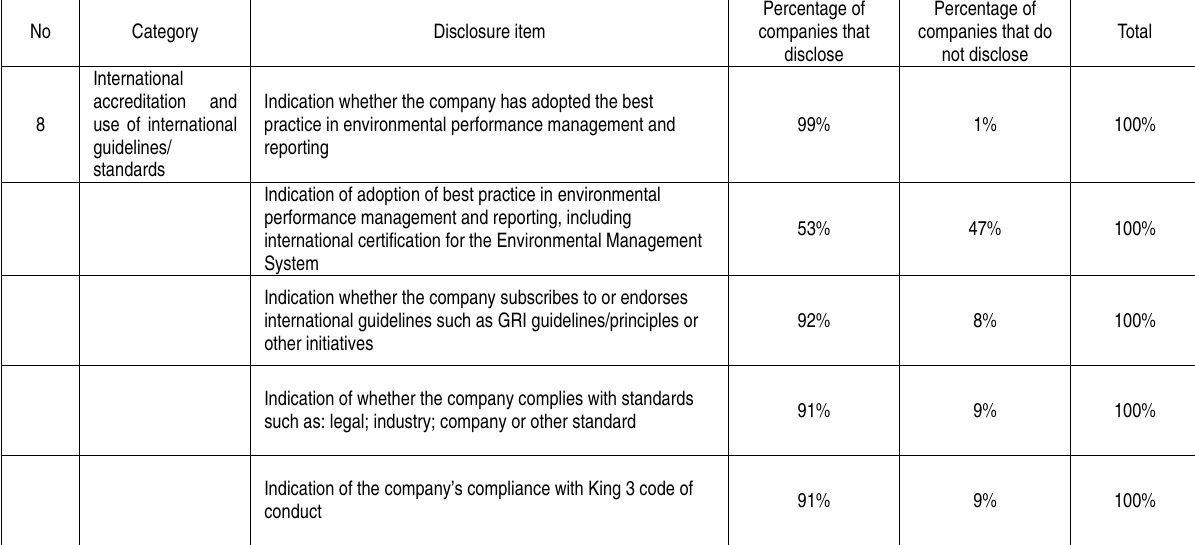
Table 4 (cont.). Disclosure of third party commentary, case studies, success stories, international accredita- tion and the use of international guidelines